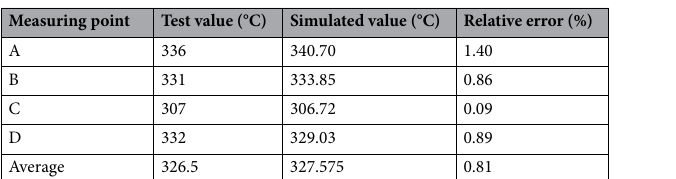
Table 6. Comparison of test results and simulation results for maximum torque condition.